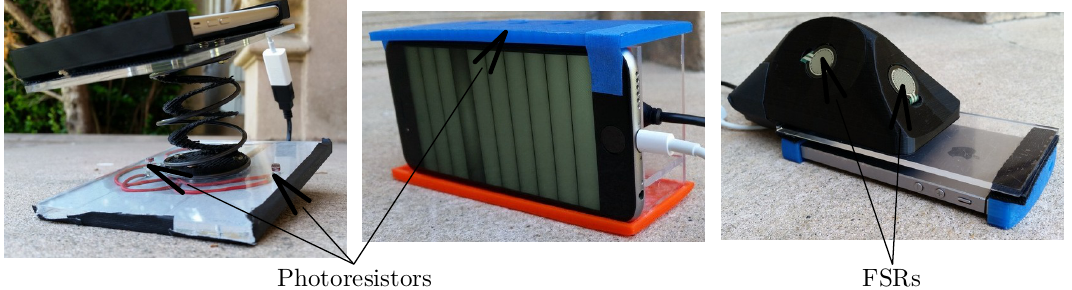
Figure 10. Bouncy-Phone by Casey Kim, Something Else by Edmond Howser, and Mobile Hang by Marit Brademann (from left to